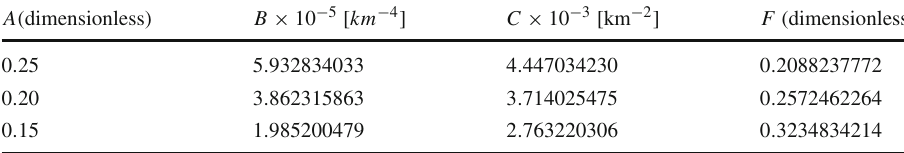
using R = 9 . 5 [ km ] and different values of the parameters A , B , C and F mentioned in Table 1. It should be noted that, as we are working in relativistic geometrized units, the vertical axis has units of [ km − 2 ] for all panels